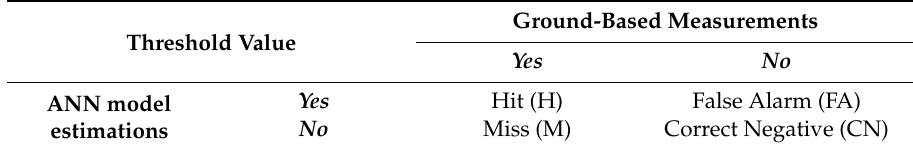
Table 2. Contingency table with calculated statistical scores used to evaluate the ability of the ANN model to reproduce AERONET AOD 550 nm values over the